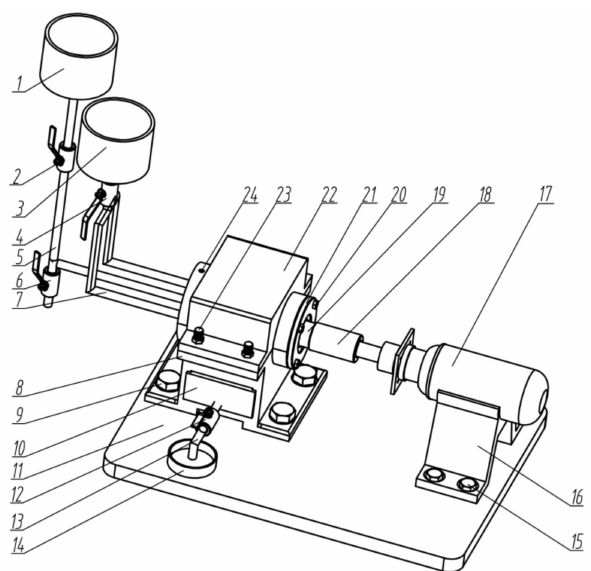
Figure 3. The appearance of the testing device. 1. Liquid container; 2. valve; 3. liquid container; 4.